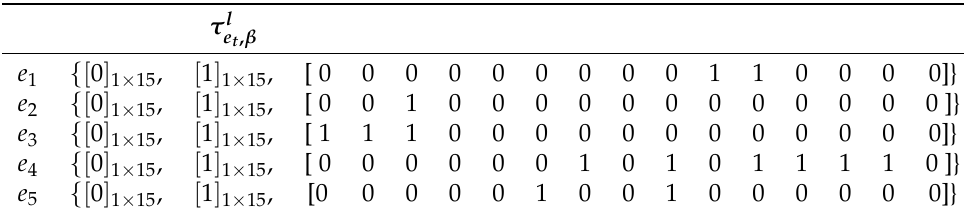
Table 10. β -Lower- e t topology; t = 1, . . .